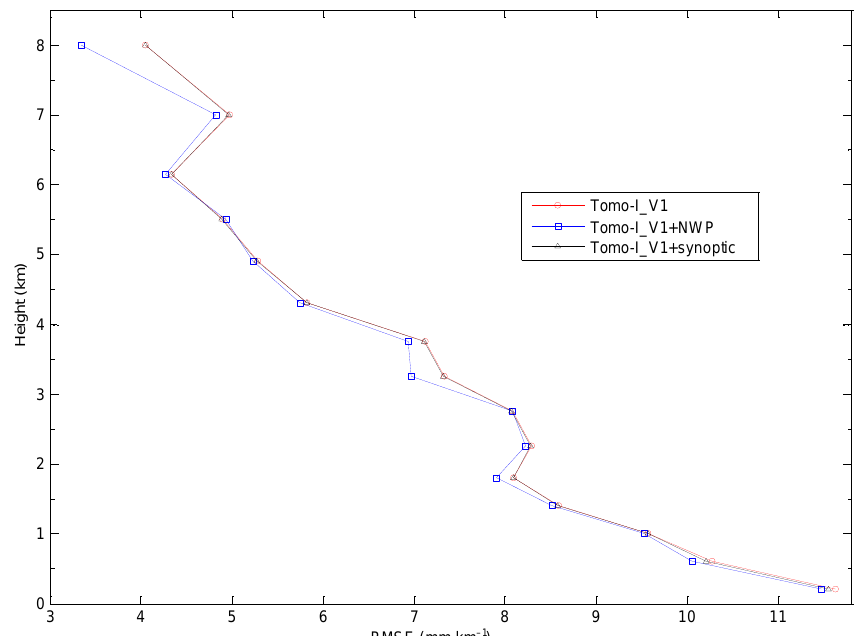
Figure 5. RMSEs of the differences between wet refractivity derived from radiosonde and tomography on different altitude layers. Based on the scheme Tomo-I_V1, tomography is performed with additional data from NWP (Tomo-I_V1 + NWP) and synoptic stations (Tomo- I_V1 + synoptic), respectively.